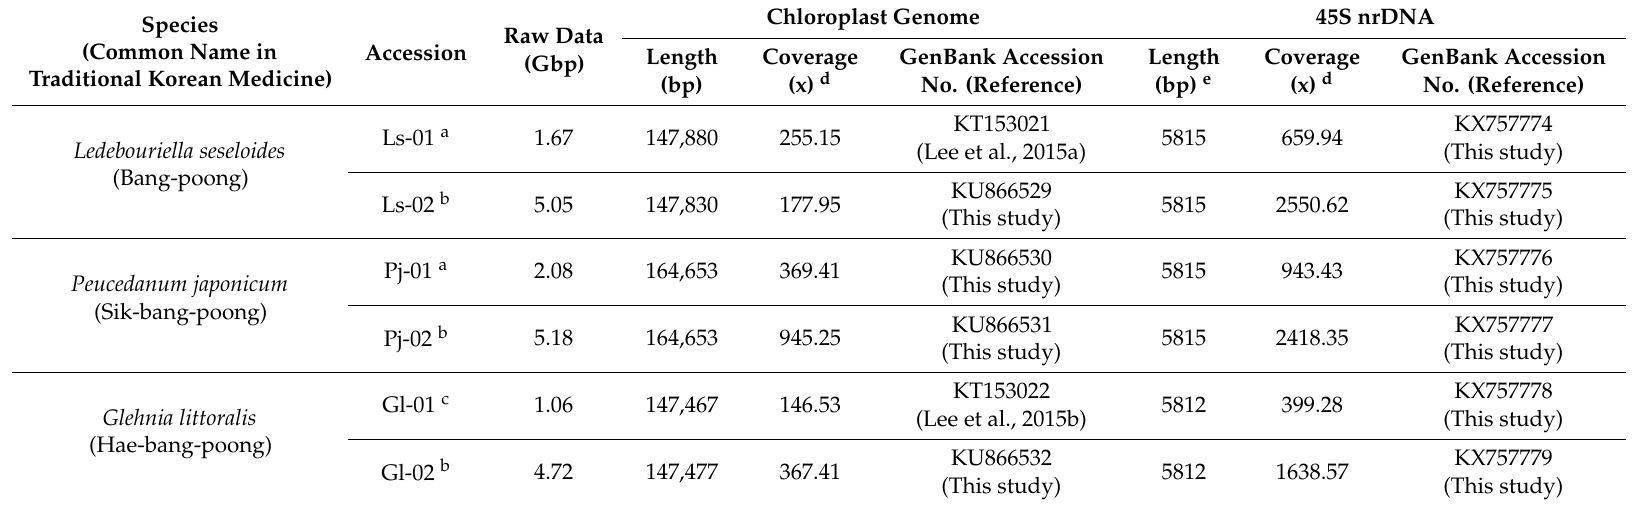
Table 1. Summary of whole-genome sequences generated and assembly status for three Apiaceae